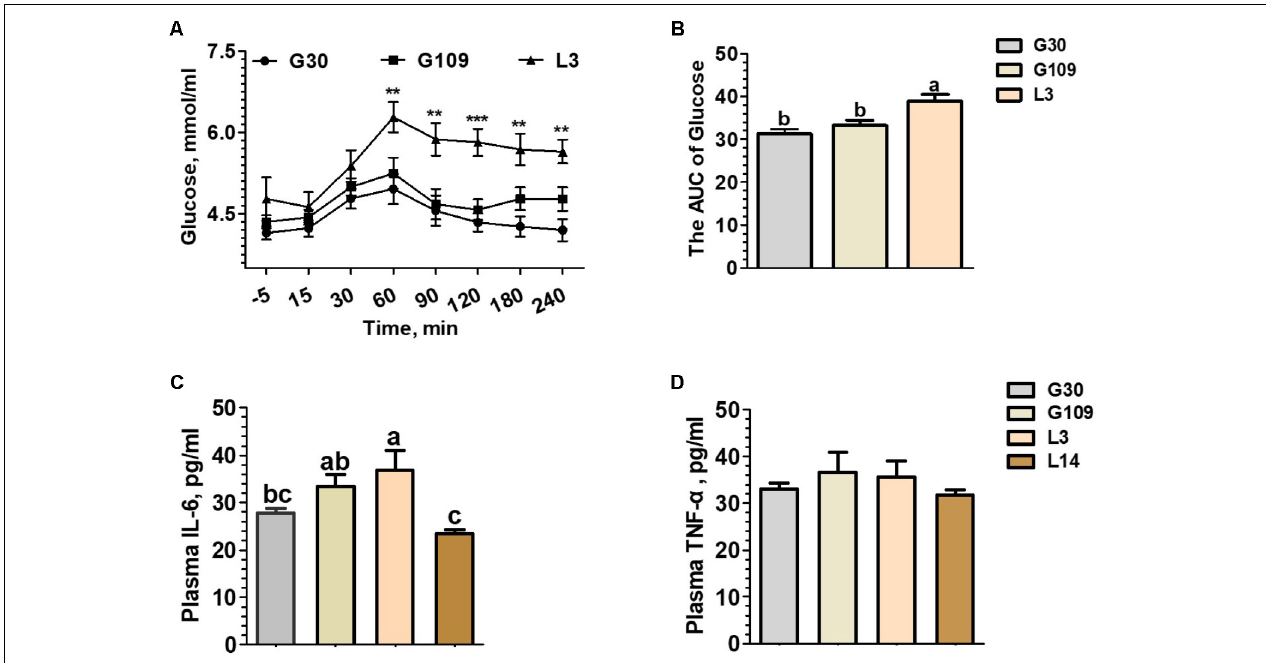
FIGURE 1 | During the perinatal period, especially in early lactation, sows showed obvious metabolic syndrome. Effects of reproductive stages on plasma concentrations of glucose (A) and the area under curve (AUC) of plasma glucose after meal tests (B) and plasma concentrations of IL-6 (C) and TNF- α (D) . Data are presented as means ± SEM ( n = 12). a,b, Significant effect of sampling day (values with different lowercase letters are significantly different). G109, day 109 of gestation; L3, day 3 of lactation. ∗∗ P < 0.01; ∗∗∗ P < 0.0001. a–c, significant effect of sampling day ( P < 0.05; values with different lowercase letters are significantly